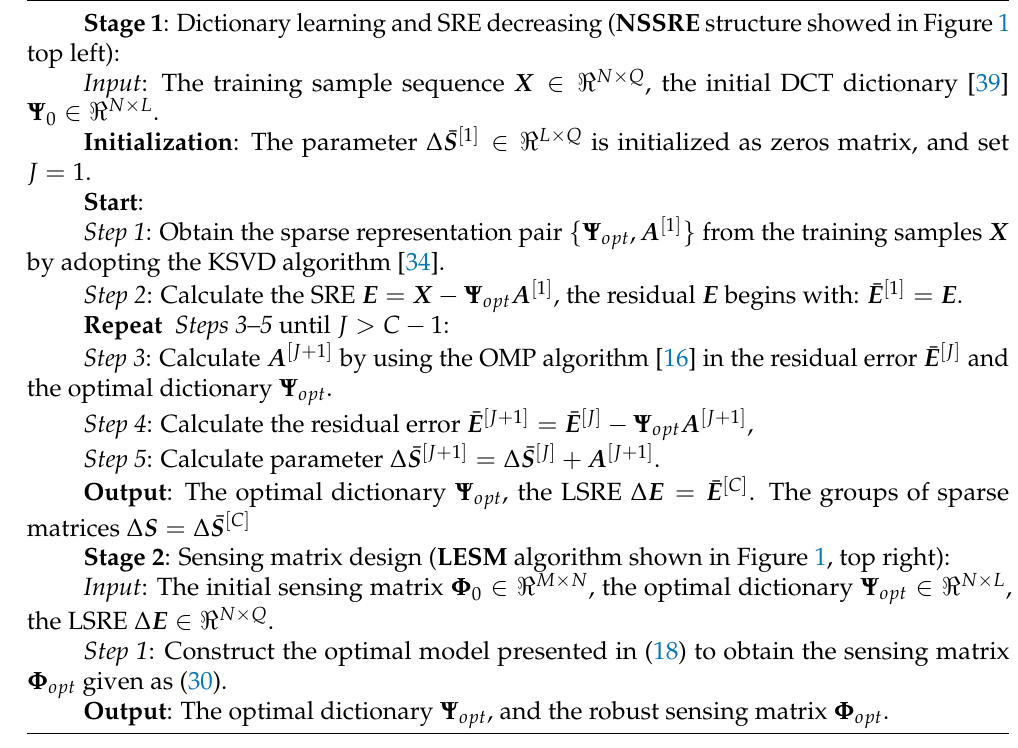
Algorithm 1 The proposed CS